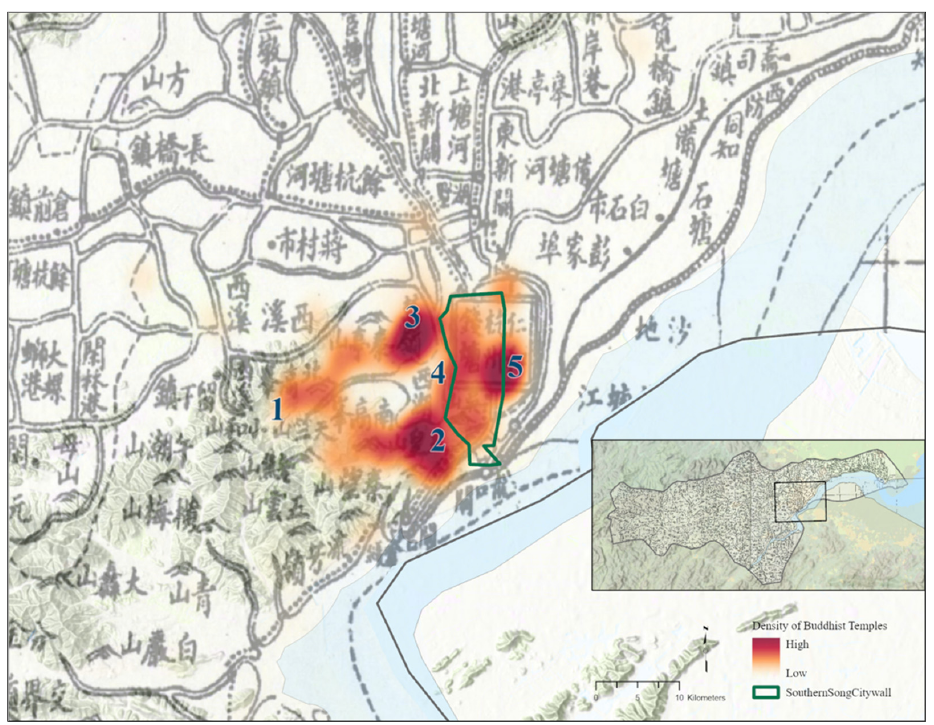
Figure 4. Kernel density of Buddhist temple distribution recorded in the Xianchun Lin’an zhi 咸淳臨安志 ( Records about Lin’an from the Xianchun Reign ). There are the following five noticeable hot zones (marked with blue numbers) on this map with higher temple density: (1) the middle-left spot located at Mt. Tianzhu 天竺山 ,